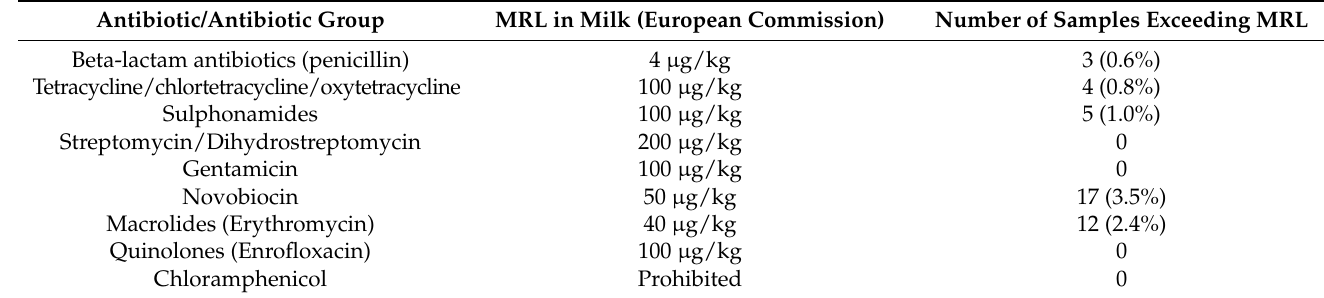
Table 2. Maximum residue levels (MRL) of the European Commission for antibiotic residues in milk, and the number of milk samples exceeding this.